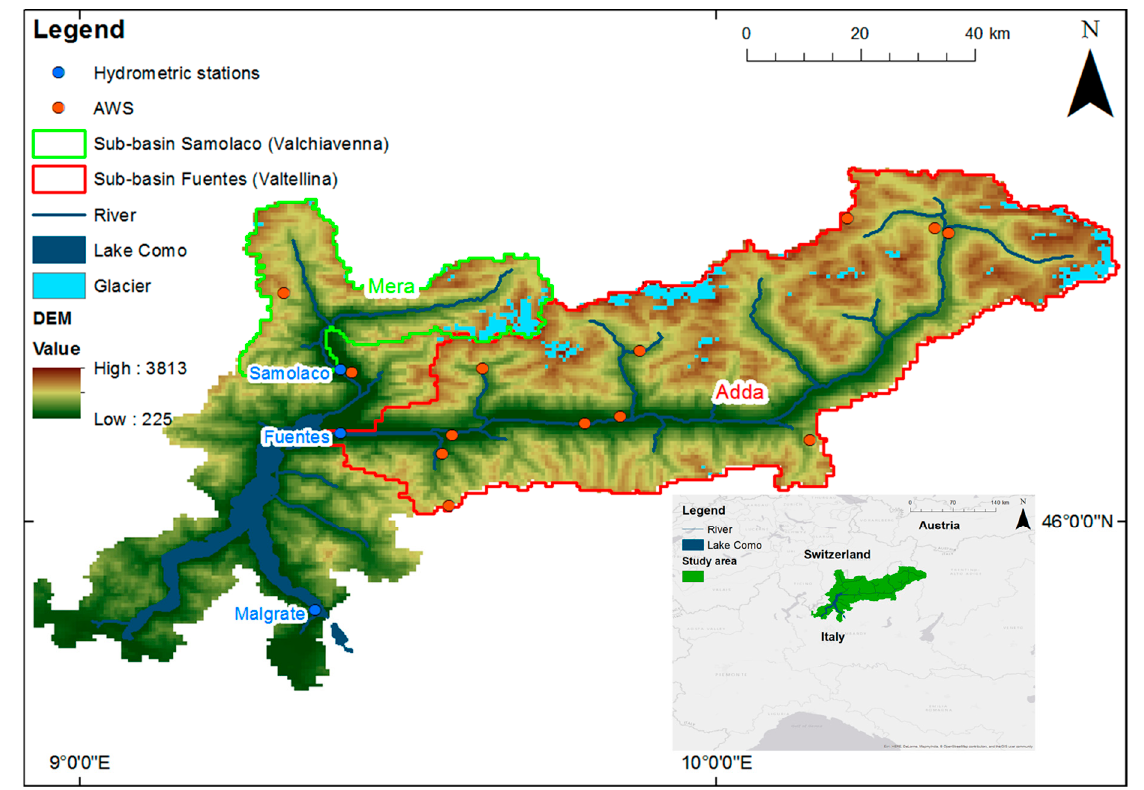
Figure 1. Case study. Lake Como catchment. Location of Automatic Weather Stations (AWS), and hydrometric (water stage) stations.